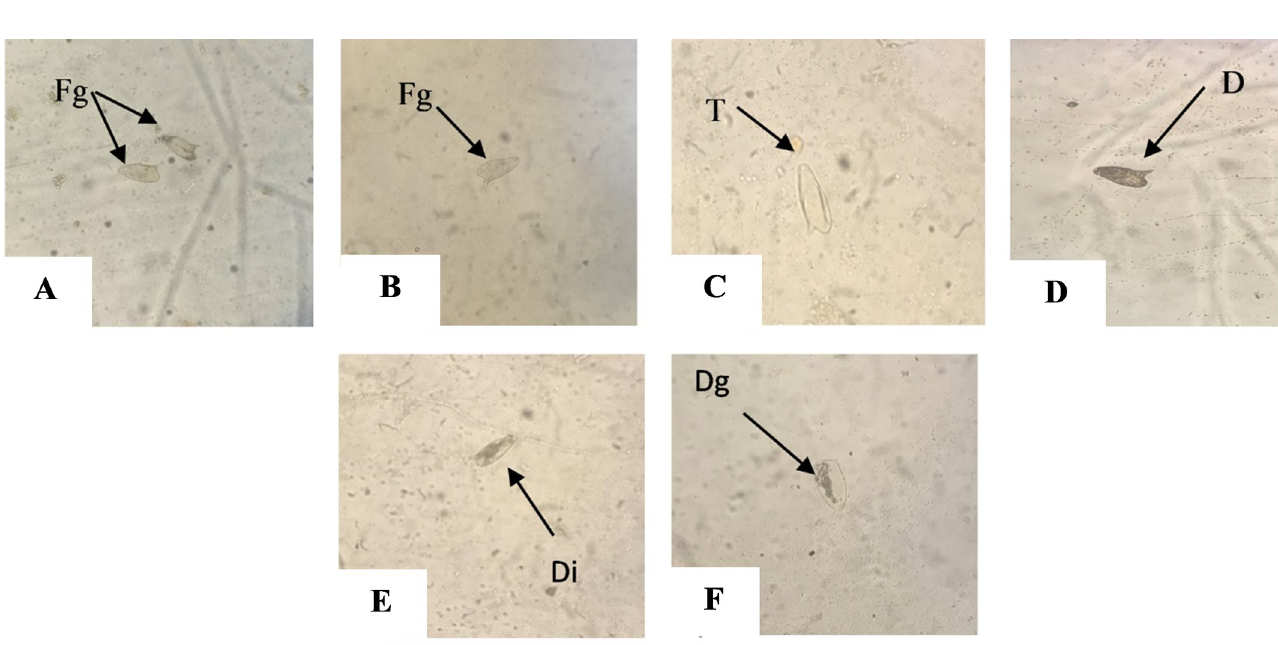
Fig 3. Morphological features of S . mansoni eggs retrieved after tissue digestion using Pellegrino’s method. ( A-D) Eggs died immaturely. ( A &B) Finely granular (Fg) eggs (X100). ( C) Transparent (T) egg (X 100). ( D ) Darkened (D) egg (X 100). (E-F) Mature eggs. (E) Disintegrated (Di) egg (X 100). (F) Egg showing dense granules (Dg) (X